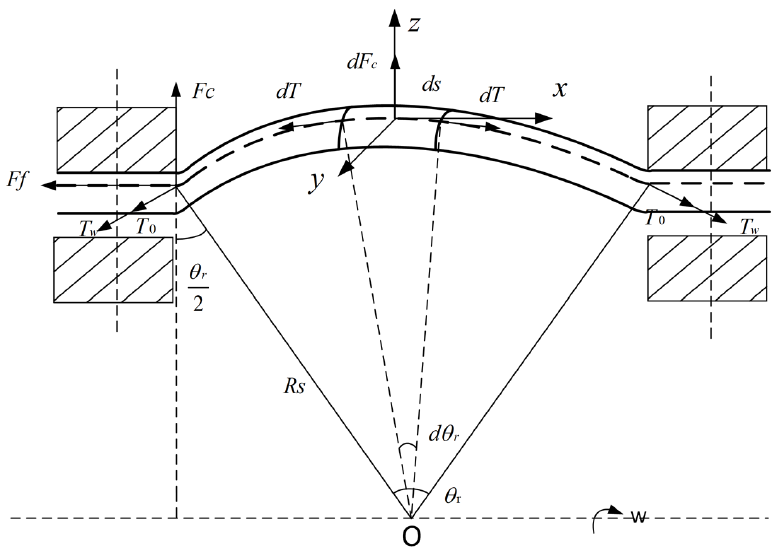
Figure 2. Analysis of the force on strands and guide holes under single span.